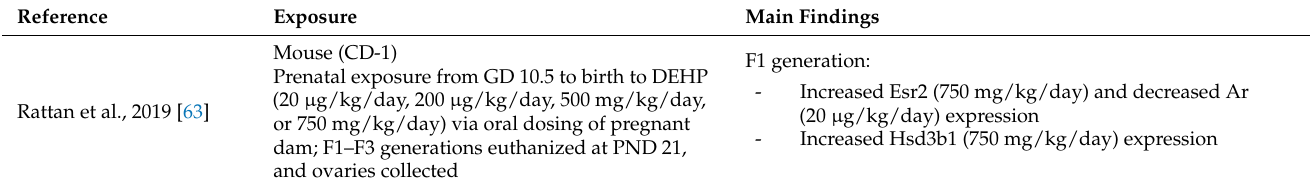
Table 3. Effects of prenatal exposure to single phthalates on female reproduction in